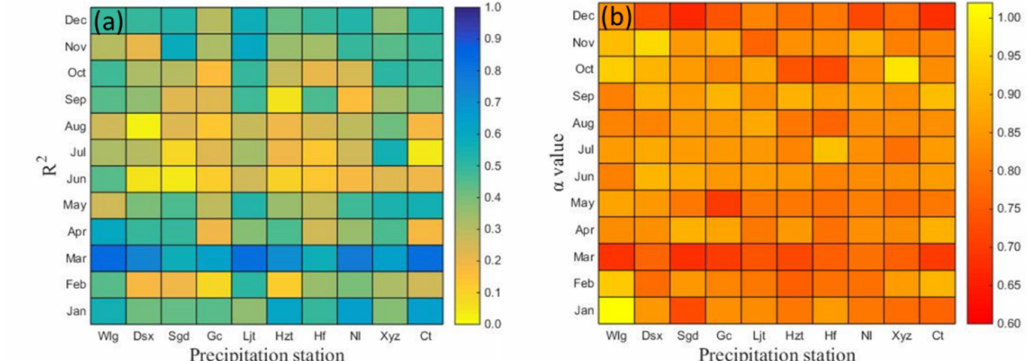
Figure 4. ( a ) The R-square value for linear fitting of P(W | D) and average monthly precipitation for each month for 10 stations in the Huangfuchuan Basin; ( b ) the calculated α value of observed data for each month for 10 stations in the Huangfuchuan Basin. The historical period is